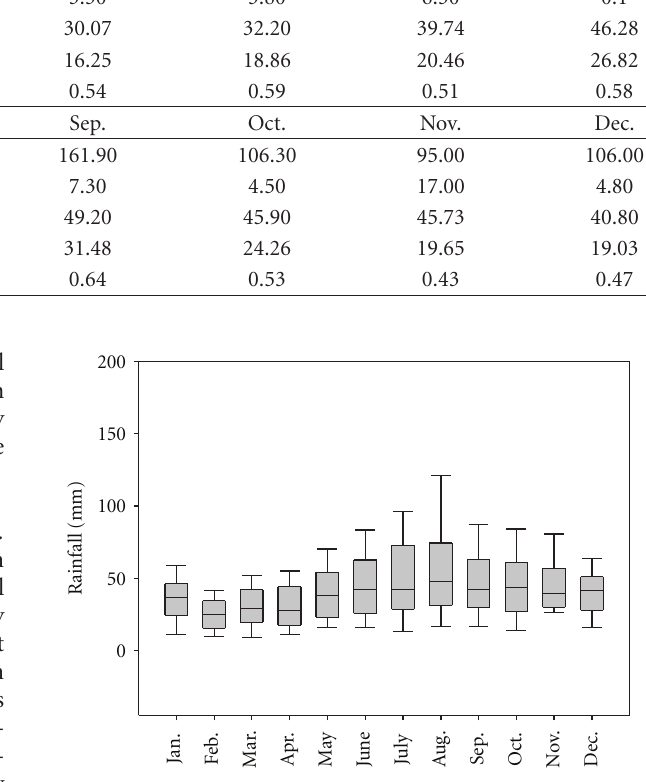
Figure 2: Monthly total rainfall in Scania, Sweden, from 1961 to 2010. Note: the boundary of the box closest to zero indicates the 25th percentile, a line within the box marks the median, and the boundary of the box farthest from zero indicates the 75th percentile. Whiskers (error bars) above and below the box indicate the 90th and 10th